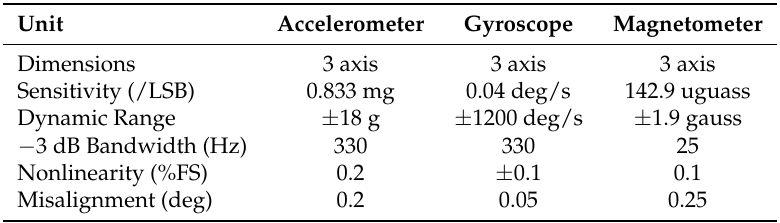
Table 1. The device parameters of the sensor